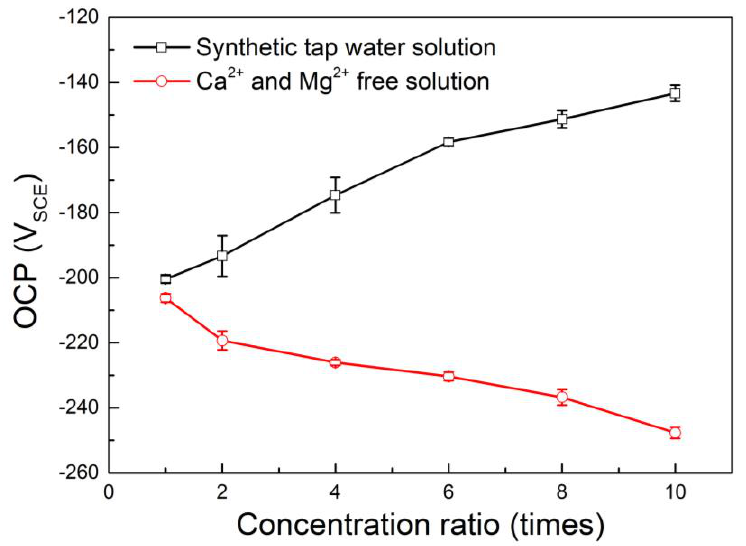
Figure 10. Variation of corrosion potential with the concentration ratio for specimens in the two solutions.